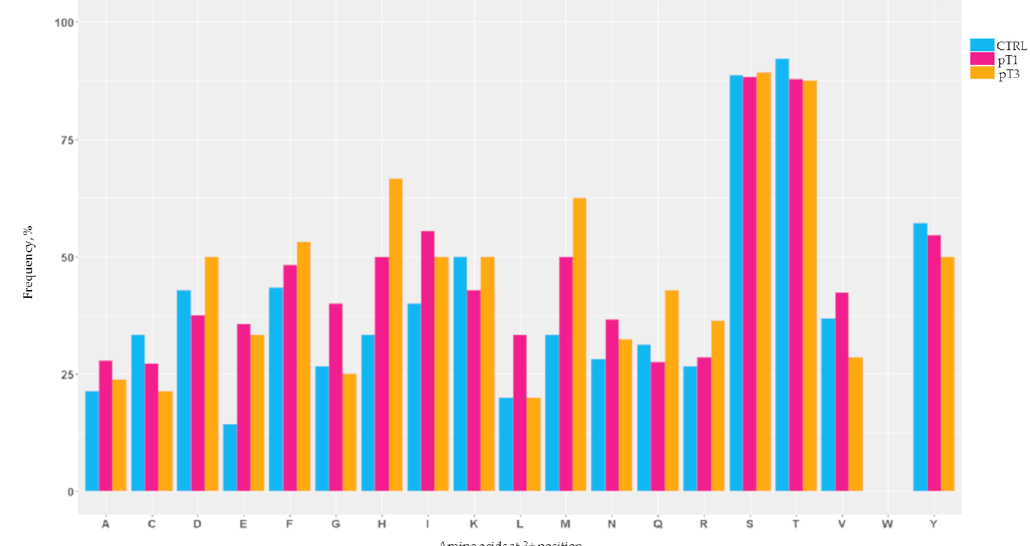
Figure 1. The frequencies of each amino acid in the +3 position in the triplet N-x-x presented in the urinary N -glycoproteome calculated for the CTRL, pT1 and pT3 groups. These frequencies were measured considering the identified peptides in all of the three cohorts.